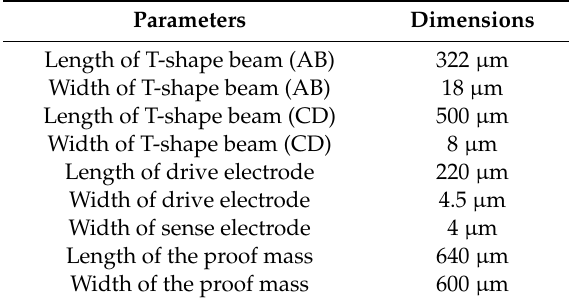
Table 1. The parameters of the MEMS gyroscope.